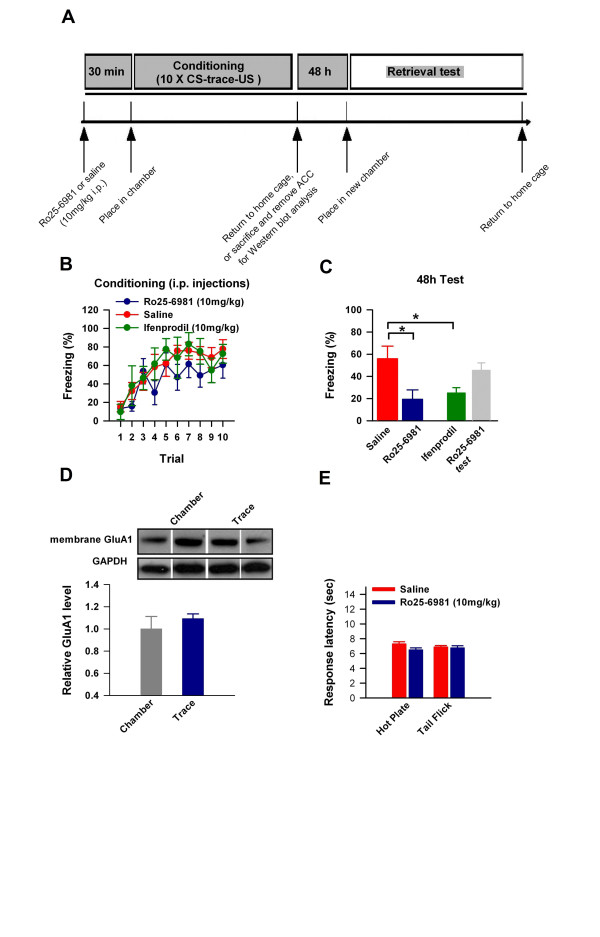
NMDA receptor GluN2B subunit activity is required for trace fear memory. (A) We exposed mice to i.p. injections of either Ro25-6981 or ifenprodil (10 mg/kg @ 2 mg/ml), or saline, 30 min prior to trace fear conditioning and assessed freezing behavior in response to the CS in a new context 48 h later. (B-C) Mice exposed to either Ro25-6981 or ifenprodil prior to training exhibited normal learning behavior but a robust reduction in freezing behavior in response to the CS compared to mice exposed to saline, or to mice exposed to Ro25-6981 30 min prior to testing. (D) Treatment with Ro25-6981 30 min prior to training completely blocked trace fear induced membrane GluA1 upregulation in the ACC (saline: n = 7; Ro25-6981: n = 8; ifenprodil: n = 6; Ro25-6981 at test: n = 5; F = 6.64). (E) Mice displayed similar response latencies in the hot plate (55°C) and tail flick assays when treated with Ro25-6981 or saline 30 min before testing. (* P < 0.02).